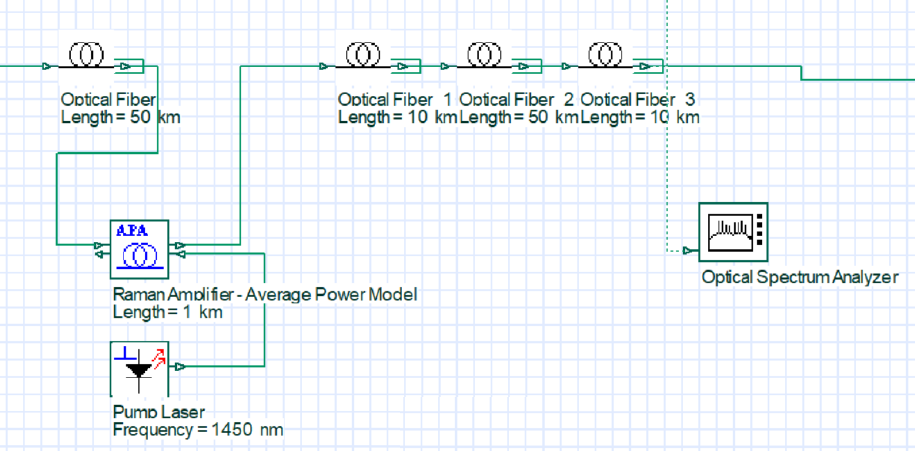
Figure 6. ROA model in our DWDM system. Table 10. Results of 32-channel ROA DWDM system.